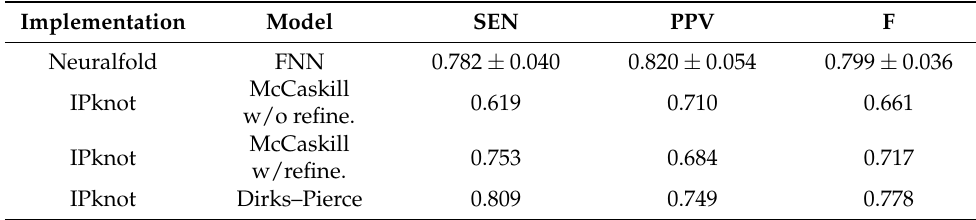
Table 2. Accuracy of inferred base-pairing probabilities for the pk168 dataset.